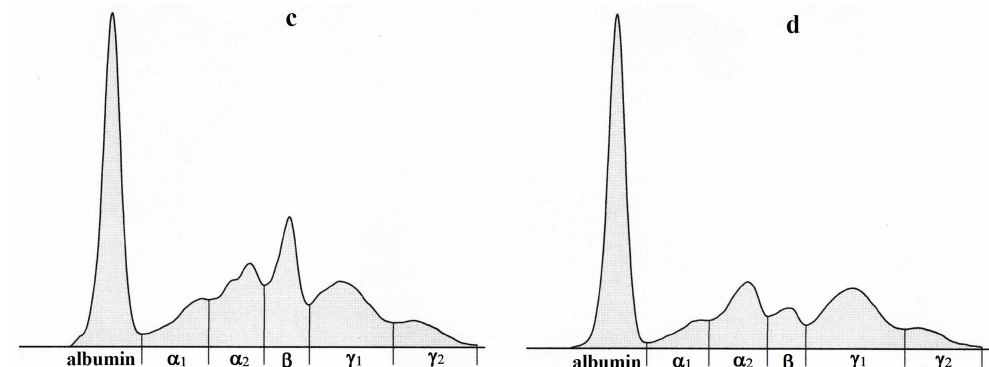
Figure 5. Representative electrophoretograms in a sheep showing the protein fractionation into six fractions: albumin, α 1 -, α 2 -, β -, γ 1 -, and γ 2 -globulins before surgical intervention ( a ) and in the postoperative period-7 ( b ), 14 ( c ) and 30 days ( d ) after